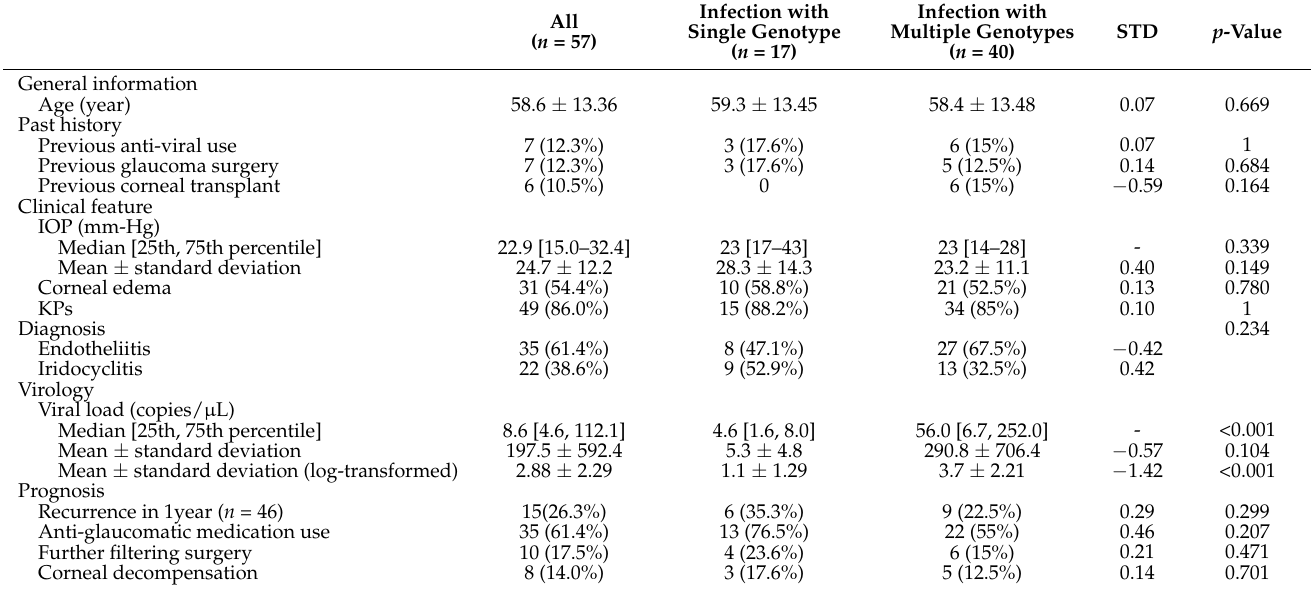
Table 1. Clinical characteristics and prognosis of patients with cytomegalovirus anterior segment infections with single and multiple